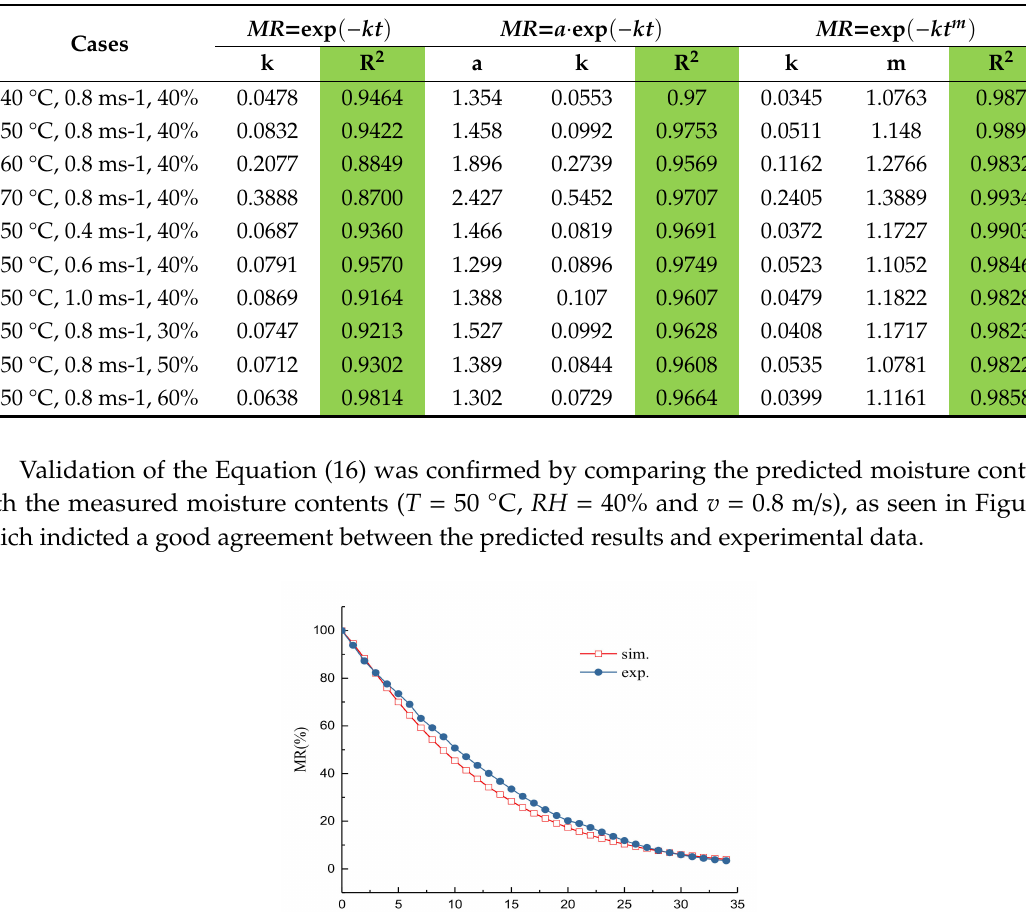
Table 4. Kinetic characteristics with temperature, velocity, relative humidity of drying air and coe ffi cient of determinations (R 2 ).